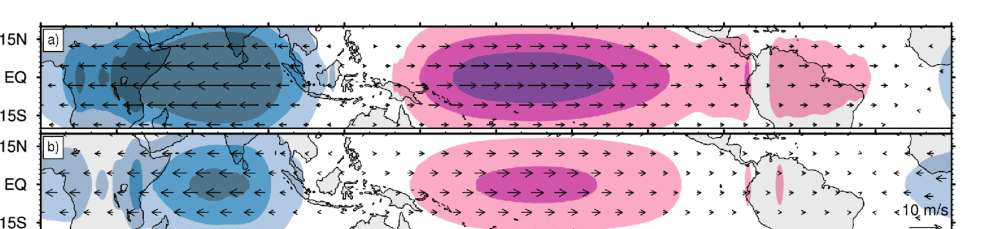
Figure 15. As in Fig. 13 but for July.